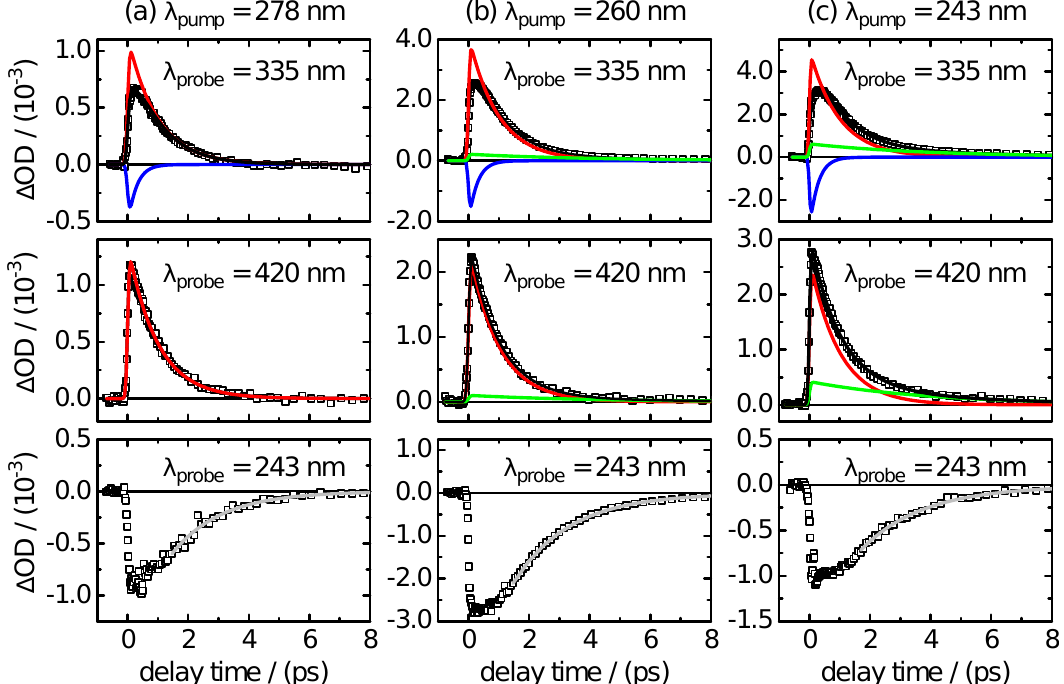
Figure 9. Time profiles of the change in optical density after excitation of XMP − at: ( a ) λ pump = 278 nm; ( b ) λ pump = 260 nm; and ( c ) λ pump = 243 nm. Open squares represent the data points and black lines the overall fit function. The single contributions are shown in blue ( τ 1 ), red ( τ 2 ) and green ( τ 3 ). The light grey lines in the bottom panels ( λ probe = 243 nm) show asymptotic single exponential fits to the observed GSR time profiles beginning at ∆ t = 1.75 ps after t 0 . Table 3. Time constant values describing the deactivation of XMP − after electronic excitation at λ pump = 278, 260 and 243 nm from the global SVD analyses of the spectro-temporal absorption maps ( (cid:104) av. (cid:105) indicates the averaged values). λ pump